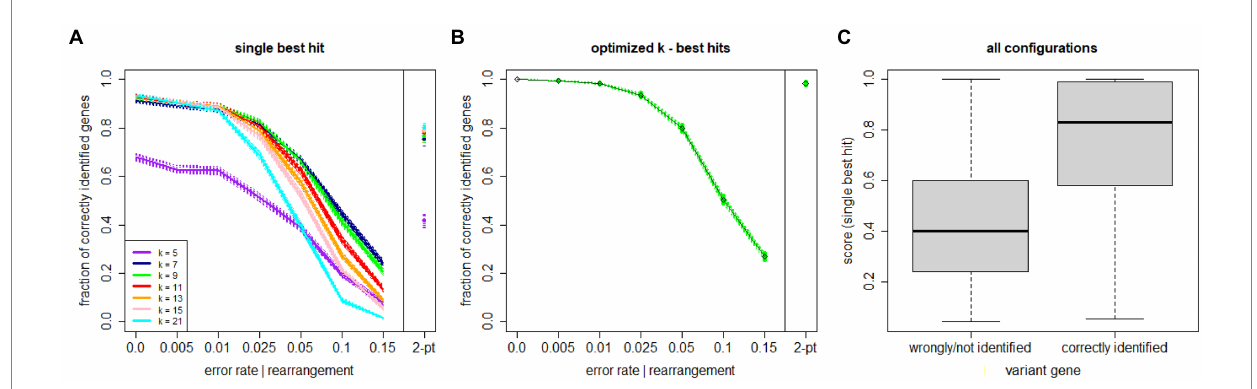
FIGURE 2 KARGVA performance on semi-synthetic data (varying error/nucleotide change rates and gene rearrangements) in identifying genes of bacteria conferring antibiotic resistance through point mutations. (A) shows performance for a single best match, stratified by parameter k value; (B) shows performance after k optimization, using all optimal best scoring matches; (C) shows box-and-whisker plot distribution of algorithm’s scores on all test configurations, stratified in accordance with ground truth. Shaded areas and whiskers represent 95% confidence intervals. Numbers used for this figure are provided in the Supplementary material.